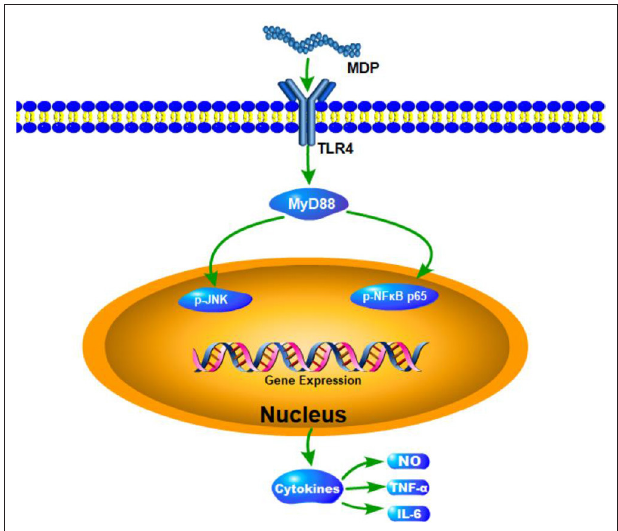
FIGURE 12 | The proposed mechanism underlying the immunological effects of